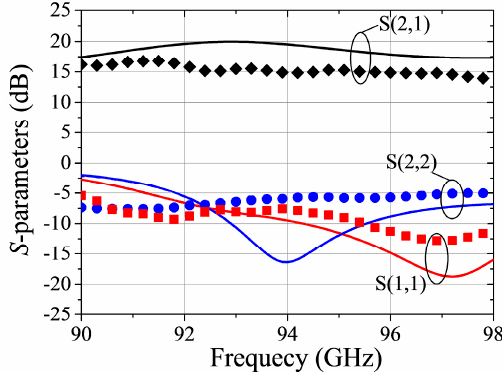
Figure 16. Measured (solid) and simulated (Symbol) S parameters of W band MMIC amplifier.